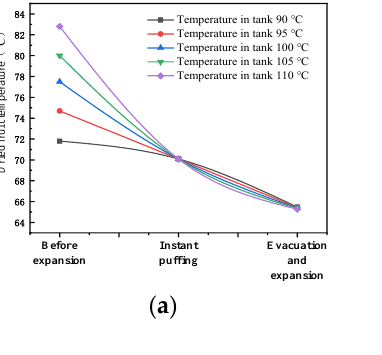
( c ) Figure 6. Effect of tank pressure on mass transfer in expansion stage. ( a ) Effect of pressure in the pressure section on drying temperature of expanded fruit. ( b ) Influence of the pressure in the pressure section on the water release in the expansion section. ( c ) Effect of pressure in the pressure section on dry fruit moisture content.